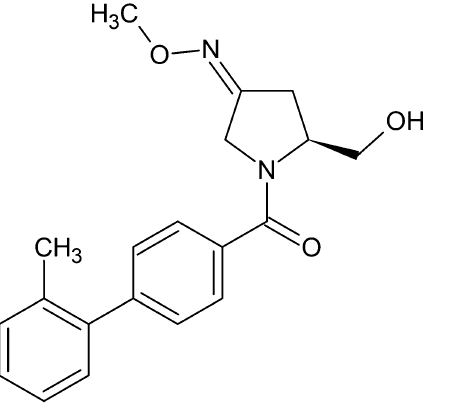
Figure 1. Chemical structure of